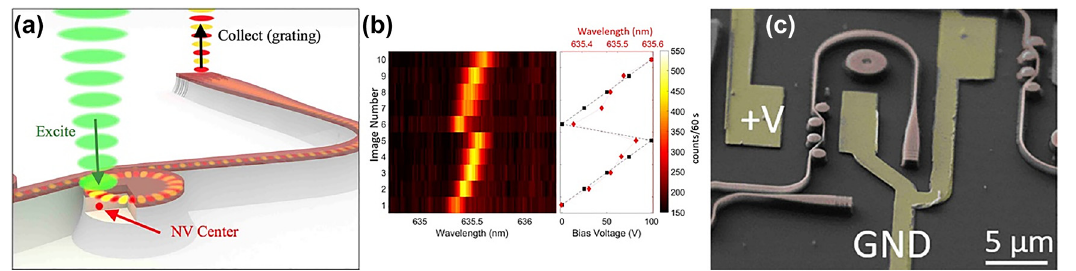
Figure 7: NV centre single photon emission coupled to GaP microdisks, with tuneable emission wavelength. (a)SchematicofNVcentrecoupledtowaveguideviaaGaPmicrodisk.(b)WavelengthshiftinsinglephotonscoupledintoGaPmicrodisksfrom NV centres, in response to changing bias voltage Reprinted with permission from the study by Gould et al. [174]. Copyright (2016) by the AmericanPhysicalSociety.(c) SEM imageof circuit. Pink: GaPmicrodisksandwaveguides; Yellow:Ti/Auelectrodesfor applyingbias voltage; Grey: diamond substrate. Reprinted with permission from the study by Schmidgall et al. [175]. Copyright (2018) American